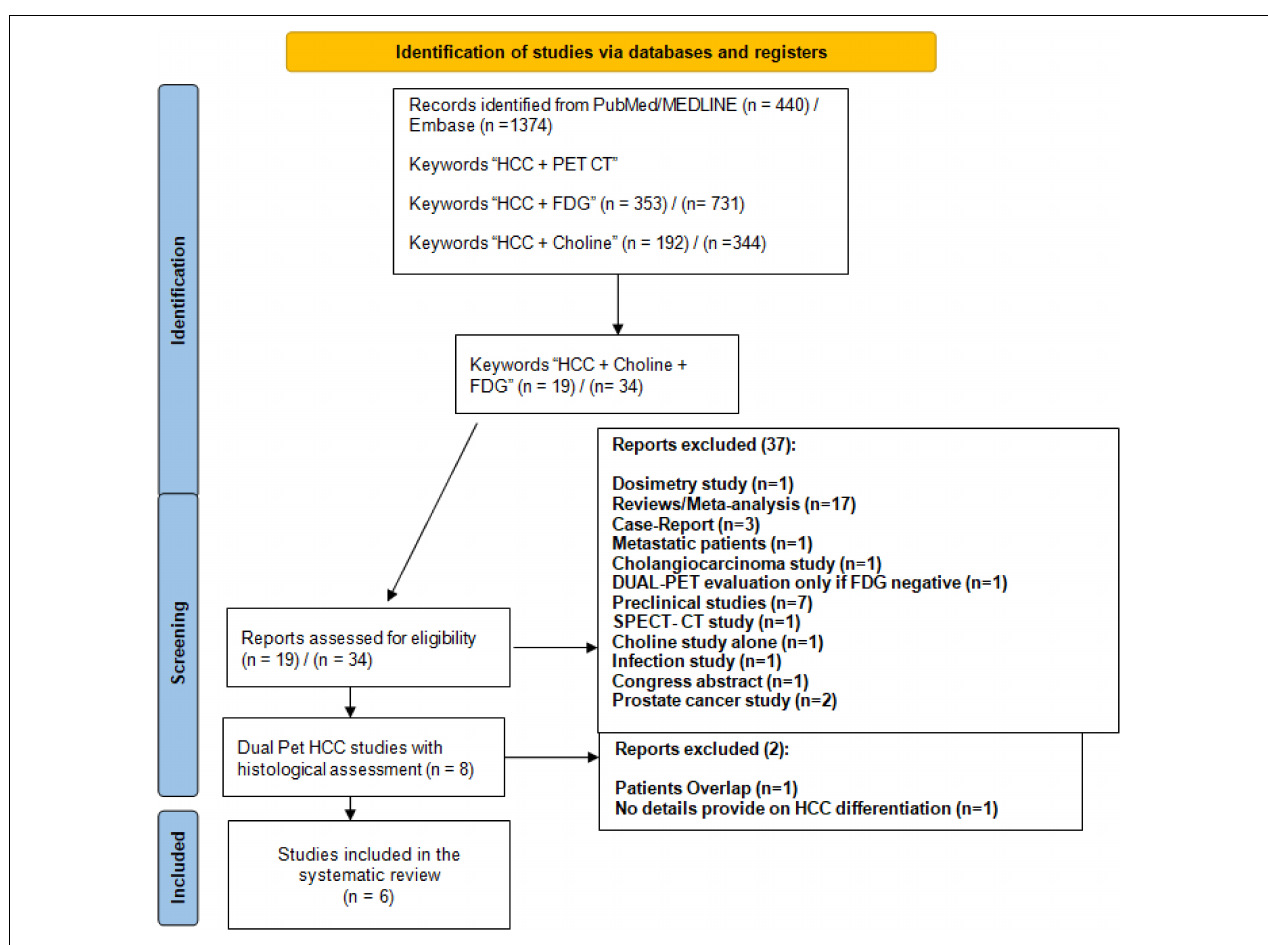
FIGURE 1 | PRISMA flowchart of the systematic